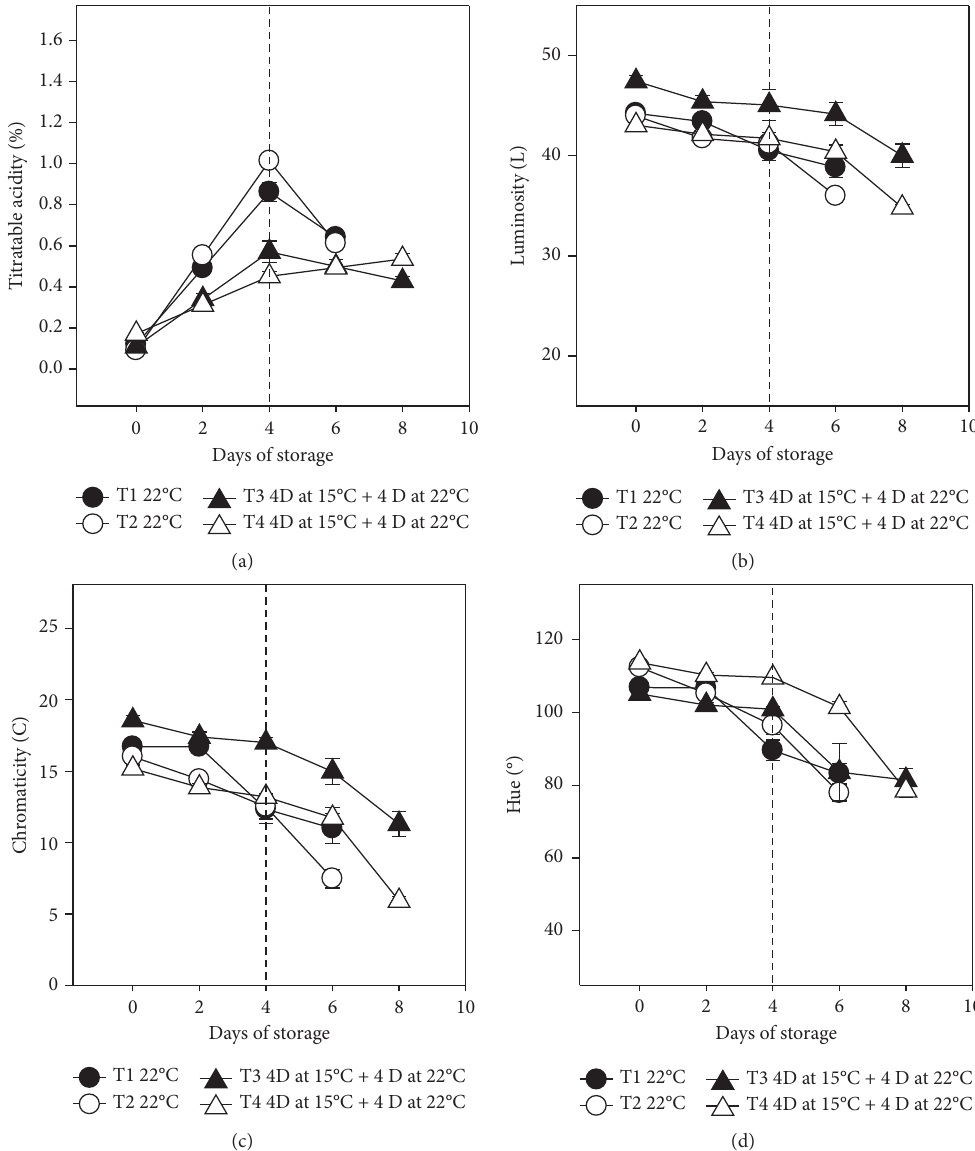
Figure 2: Titratable acidity (a) and color parameters: luminosity (b), chromaticity (c), and hue angle (d) in soursop fruits stored at 22 ° C and 15 ° C. Each point represents the average of six observations and its standard error. The dotted line indicates the end of refrigeration